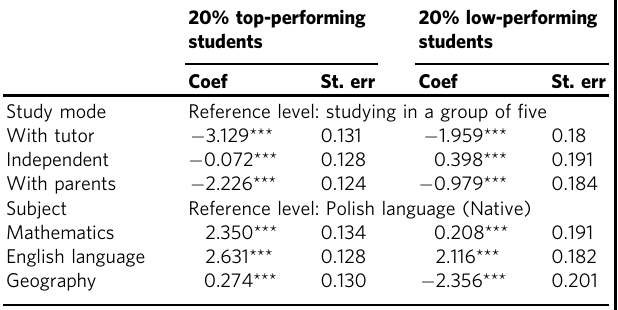
Table 4 Willingness to pay calculated based on multinomial logistic regression for 20% highest- and lowest-performing students in mathematics.